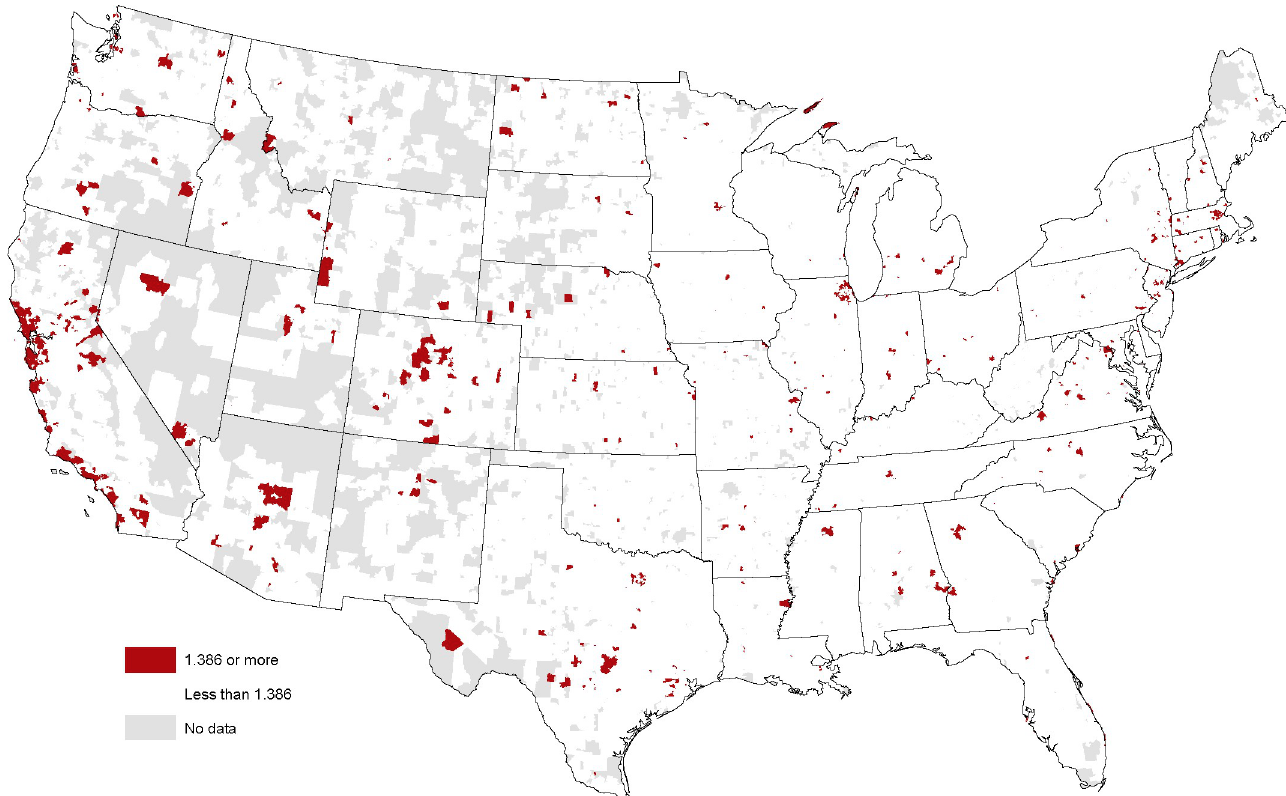
Fig 1. Entrepreneurship hotspots (index > 1.386) mapped at ZIP code level, January 2018. Sources: Esri, DStillery Custom Crafted Audience. Maps were created using ArcGIS 1 software by Esri. ArcGIS 1 and ArcMap ™ are the intellectual property of Esri and are used herein under license. Copyright Esri. All rights reserved. For more information about Esri 1 software, please visit www.esri.com.